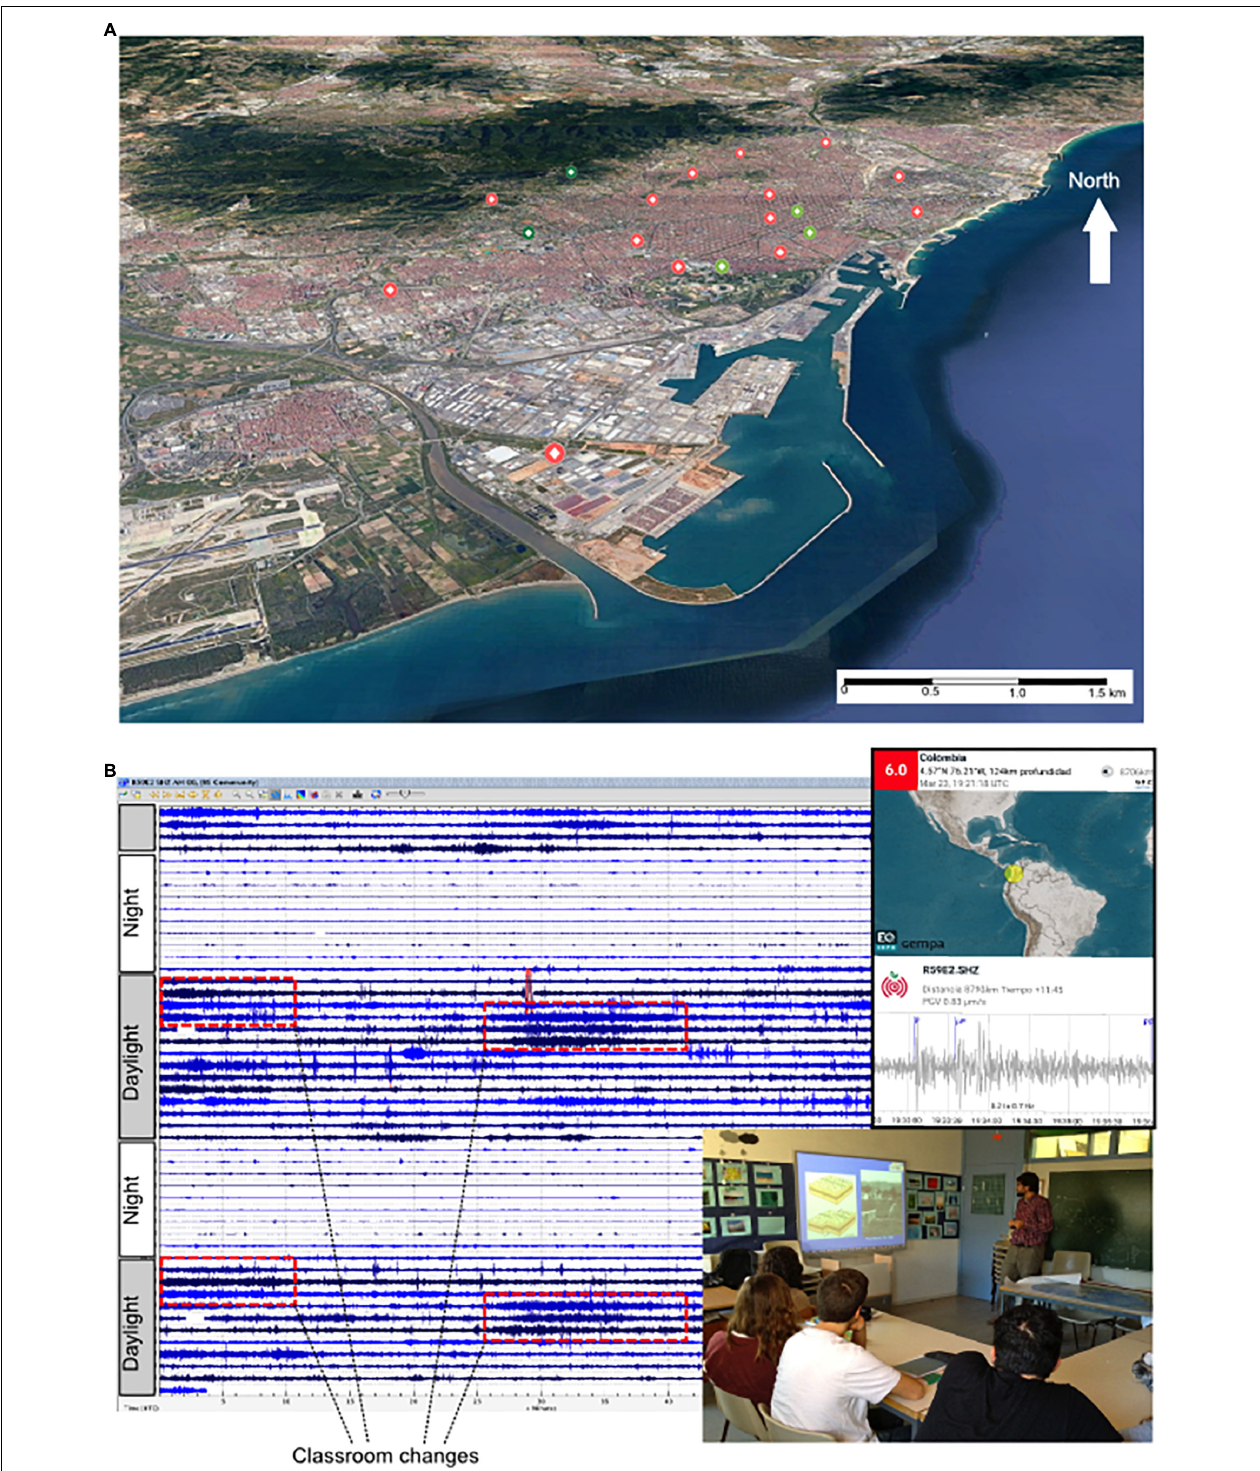
FIGURE 2 | Deployment of seismic stations in secondary schools. (A) Map view of the seismic stations deployed in secondary schools within the Barcelona area. Red dots show the newly deployed stations, while light and dark green dots show the available broad-band and accelerometric stations. (B) Example of seismic records in a secondary school in Barcelona (1 h per line) clearly showing the day/night variations and the scholar activity pattern; red dashed boxes show the 5 min-long periods of larger noise observed every hour during classroom changes. The upper side panel shows an example of the seismic alerts that can be received by the students using mobile phone apps, while the lower side panel illustrates the dissemination talks given in schools.